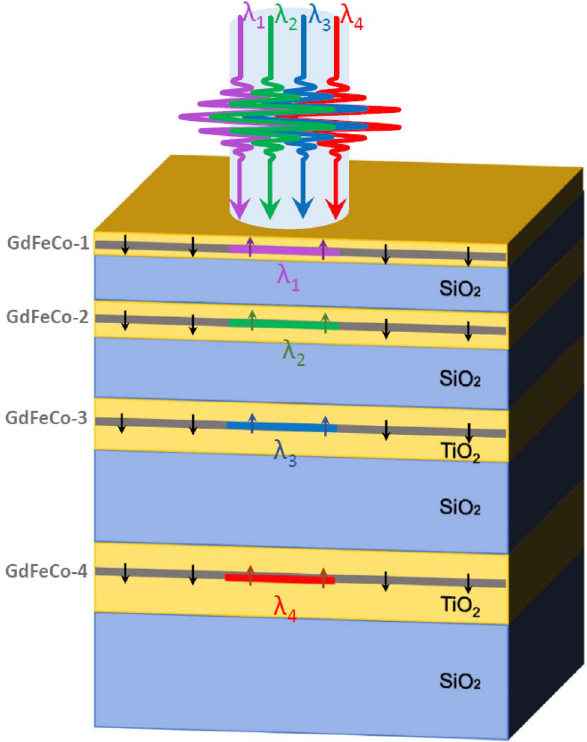
Figure 1. A scheme of the addressed chirped magnetophotonic crystal with thin GdFeCo layers. TiO 2 layers (yellow) alternate with SiO 2 layers (blue). Grey areas indicate the GdFeCo layers introduced into TiO 2 . Depending on the wavelength of the input femtosecond pulse, the different GdFeCo layers experience remagnetization due to the heating. This process is illustrated by multi-colored rectangles. For example, if the structure is illuminated at wavelength (cid:31) 1 , then the energy absorbed in the GdFeCo-1 layer exceeds the threshold while it remains below the threshold for all other GdFeCo layers. As a result, only GdFeCo-1 layer is switched, while magnetization in all other layers remains untouched. The magnetization direction in GdFeCo layers is shown by small arrows. The dimensions and proportions are not respected and are chosen just for ease of perception (for the correct dimensions see Table 1).